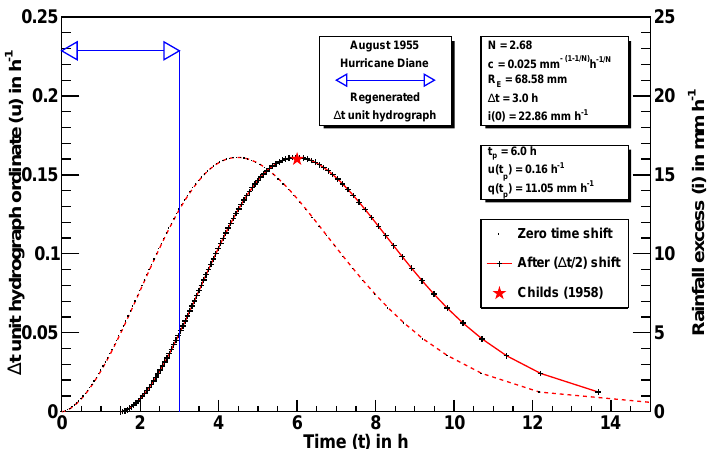
Fig. 8a. Regeneration of the 3-hour unit hydrograph for the Naugatuck River in Connecticut, by the direct Bakhmeteff function method of convolution, for the Hurricane Diane in August, 1955. For comparison, the peak characteristics reported by Childs (1958) are shown as a red star.